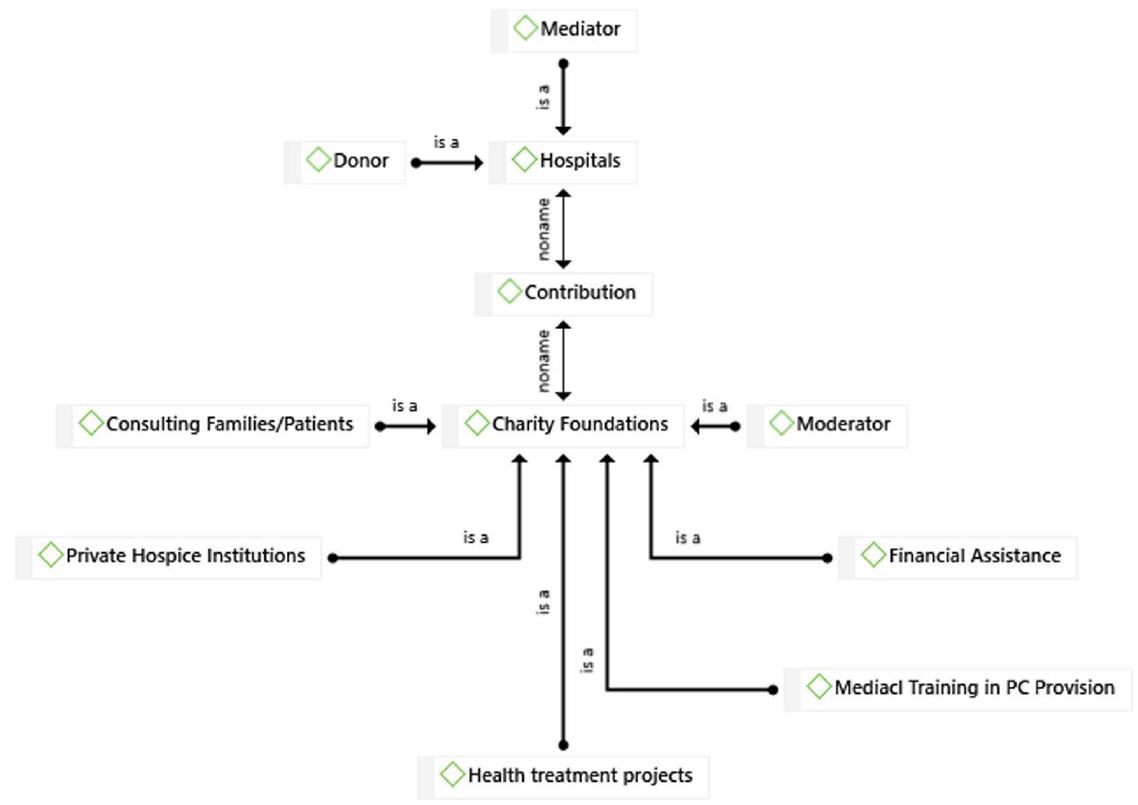
Figure 2. Contribution of charity foundations and hospitals to the palliative care